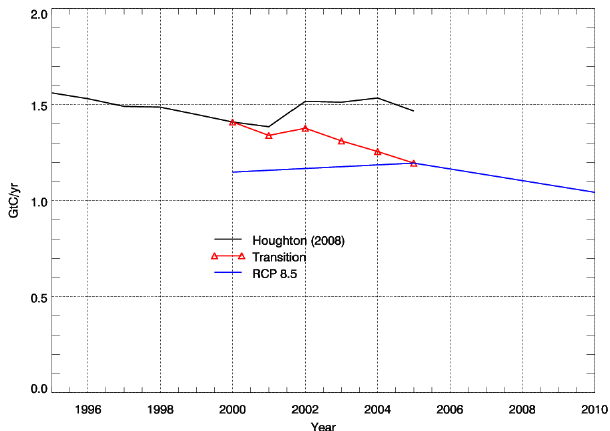
Fig. 4. Total CO 2 emissions used to force HadGEM2-ES for the emissions-driven historical and future RCP8.5 simulation. Total CO 2 emissions (black) and the individual components of fossil fuel emissions (blue) and LUC emissions